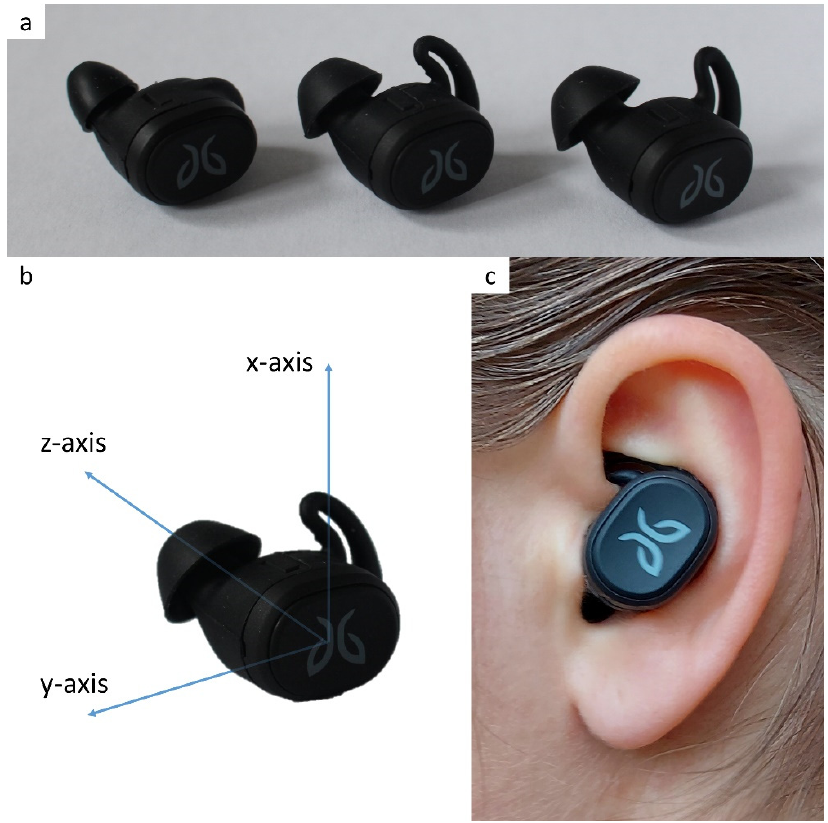
Figure 2. Instrumented wireless earbud. ( a ) Three earbuds with differently sized attachments. ( b )